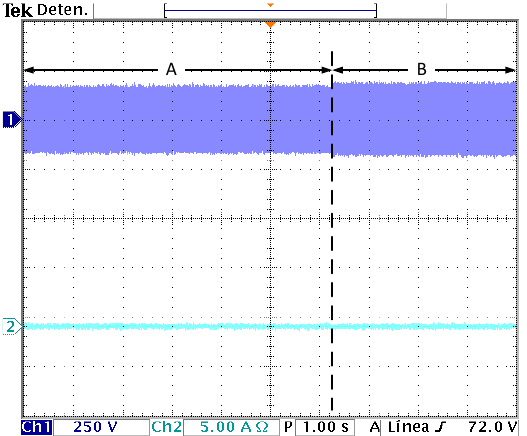
Figure 12. Node voltage increment due to PV injected current increment in the system, which turned off the system. A: V N = 120 V RMS and B: V N = 130 V RMS . From top to bottom: node voltage and injected current.